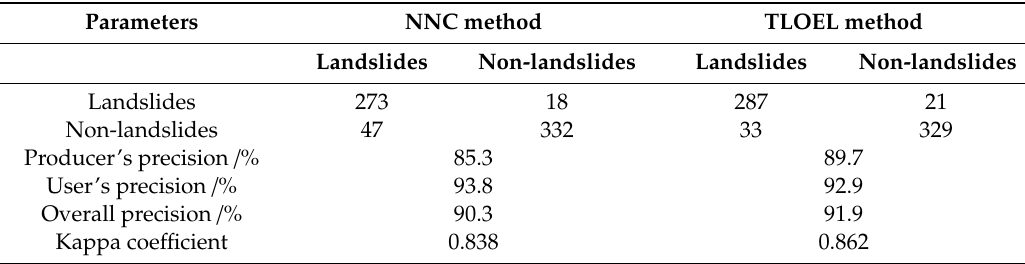
Table 5. Confusion matrix of experimental image 2.